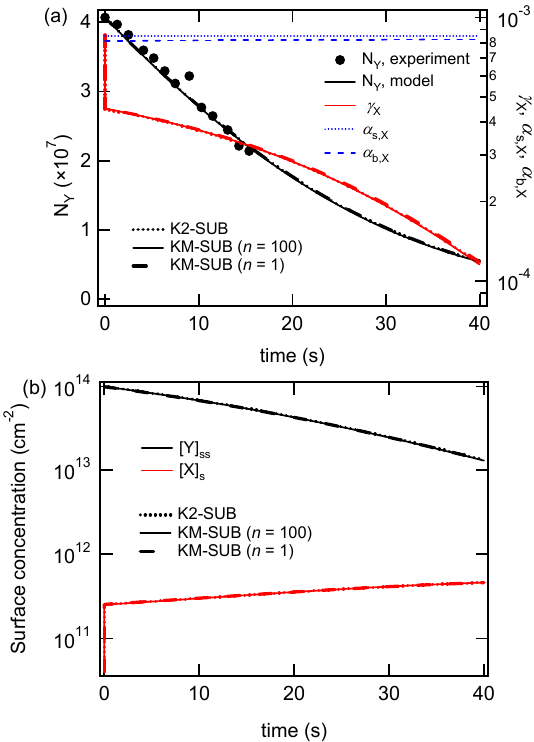
Fig. 5. Temporal evolution of model base case 2 in KM-SUB with 26 n = 1 (dashed lines) and n = 100 (solid lines) and in K2-SUB (dot- ted lines). (a) Experimental data (black symbols; Ziemann, 2005) and model results for the total number of oleic acid molecules ( N Y , black line) and for the uptake coefficient of ozone ( γ X , red line), sur- face accommodation coefficient ( α s , X , blue dotted line), and bulk accommodation coefficient ( α b , X , blue dashed line). (b) Surface concentrations of oleic acid (black line) and ozone (red